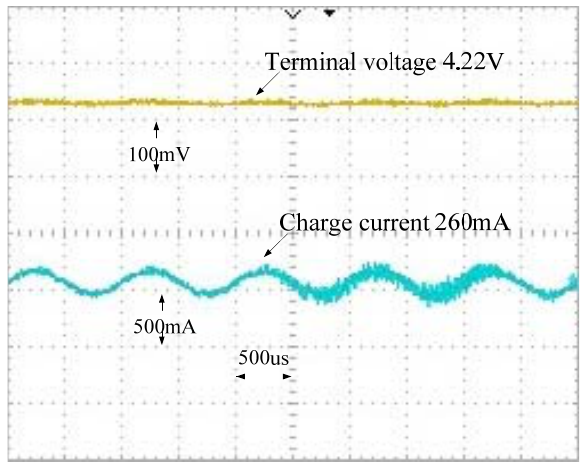
Figure 14. The charge current and the terminal voltage waveforms.